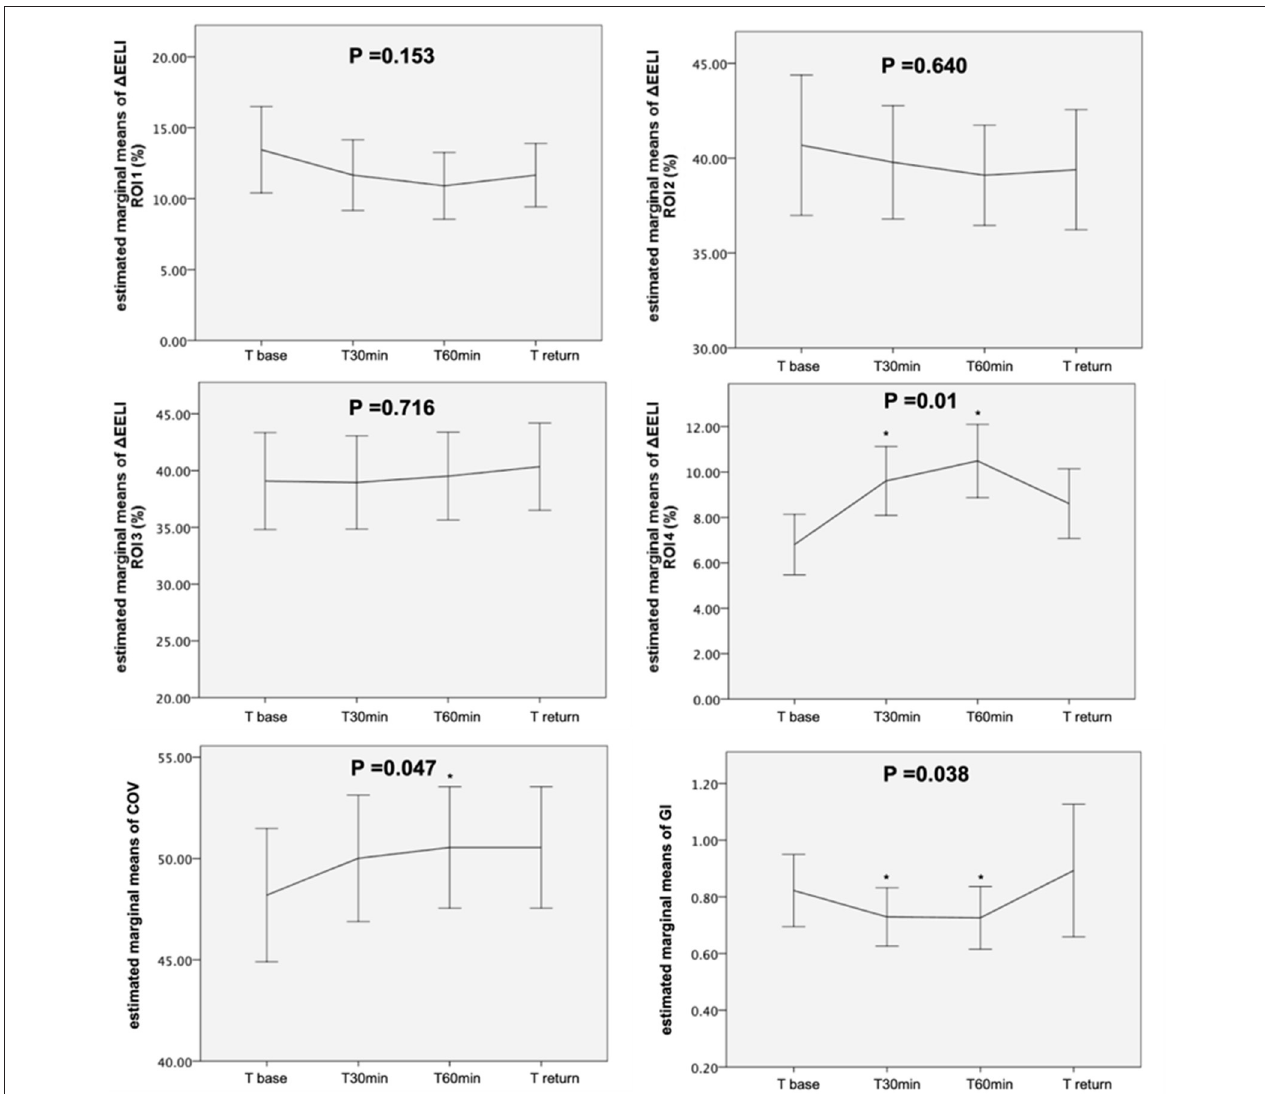
FIGURE 1 | Evolution of the estimated marginal means of ROI 1–4, GI, and COV at different time points. ROI, region of interest; GI, global inhomogeneity; COV, center of ventilation; p value by general linear model repeated measures. * p < 0.05 indicates a significant difference between this time point and T base .